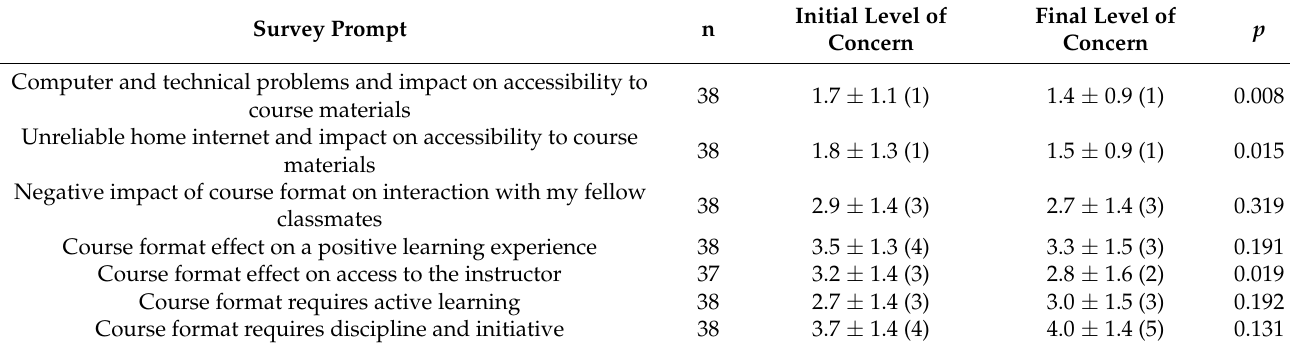
Table 2. Mean Likert scores associated with the following survey questions: how concerned were you about the following issues, as they related to your participation in an online veterinary medicine course? and Now that you have completed the online toxicology course, how big of a barrier did these issues represent? Survey prompts have been modified to account for word tense. Bold text indicates a statistically significant difference. Median values are provided in parentheses. A five-point Likert scale (not at all = 1, slightly = 2, somewhat = 3, moderately = 4, extremely = 5) was used for each of these questions.